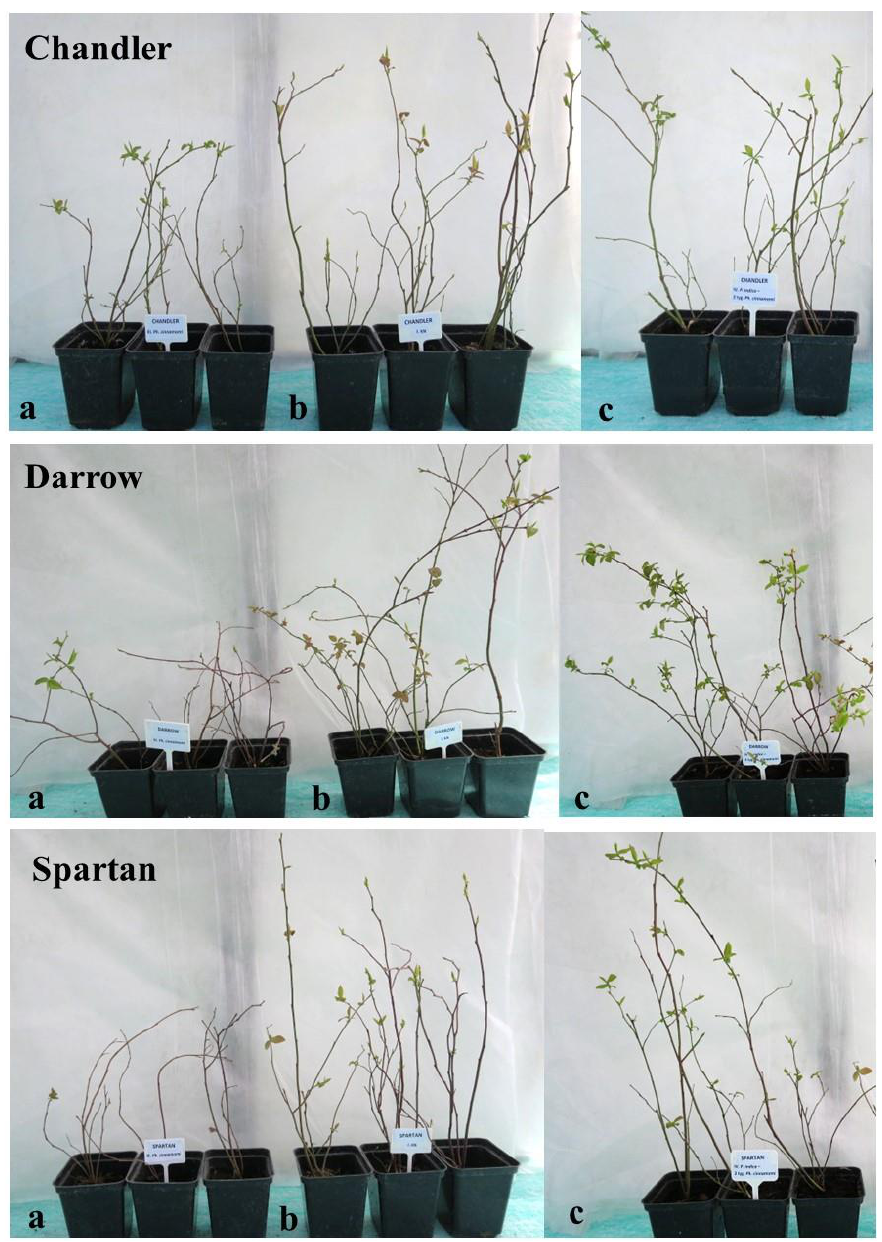
Figure 3. Influence of inoculation of S. indica and P. cinnamomi on highbush blueberry plants after 18 months of the experiment. Each of three plants from the left: ( a ) infected with P. cinnamomi , ( b ) control (not inoculated), ( c ) inoculation with S. indica, and after 21 days infected with P. cinnamomi.